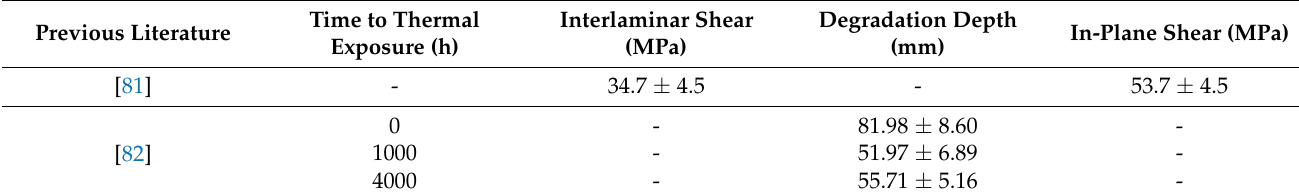
Table 2. Degradation and shear properties of glass fibre composites in respect to